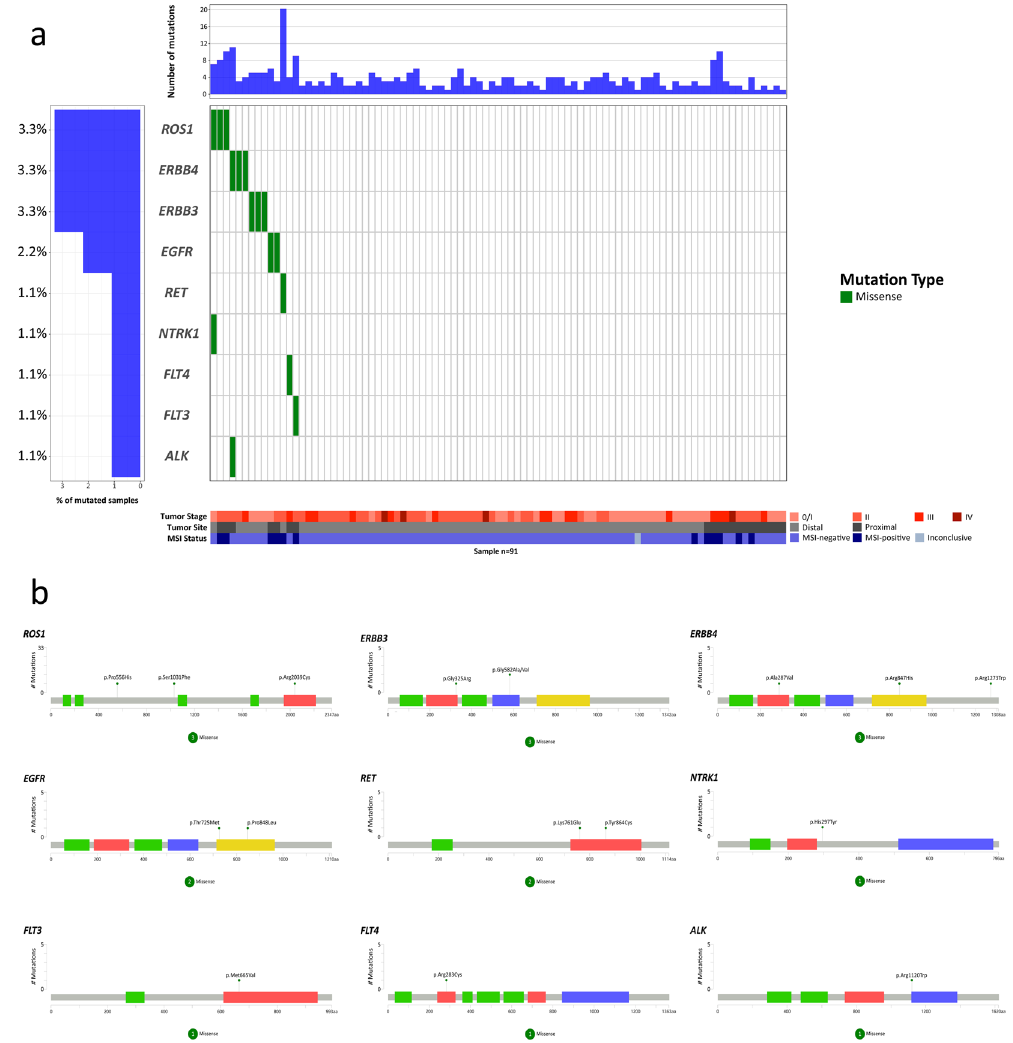
Figure 5. Waterfall (oncoplot) plot ( a ) and mutation mapper of RTK genes. Tumor stage: stage of the disease at diagnosis. MSI: microsatellite